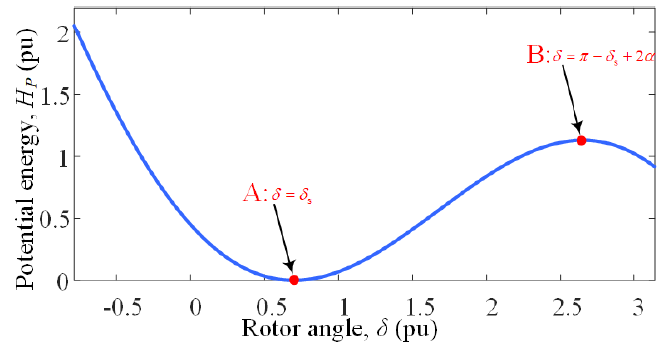
Figure 2. Potential energy curve near the stable point.